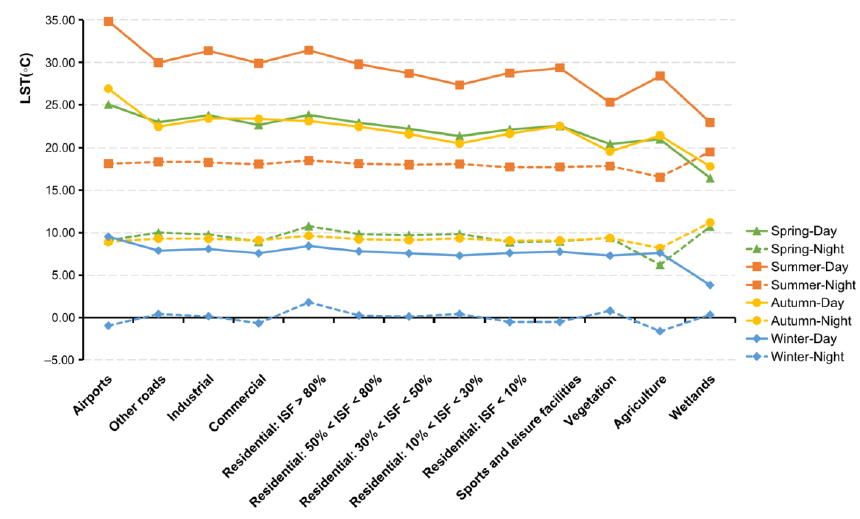
Figure 6. Seasonal variability of the average LSTs by detailed land cover